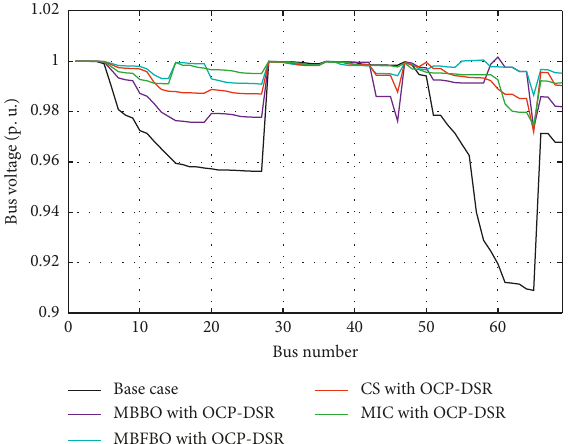
Figure 8: Voltage profile for 69-bus RDS using OCP-DSR technique.